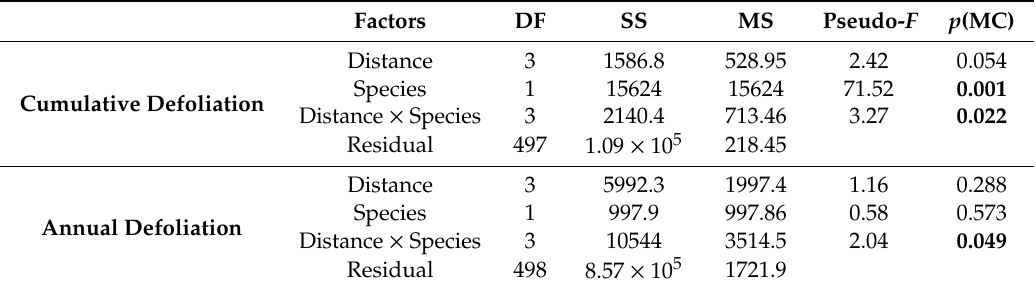
Table 3. Results of a permutational multivariate analysis of variance (PERMANOVA) for cumulative and annual defoliation among distance, species, and distance × species, including degrees of freedom (DF), sum of squares (SS), mean squares (MS), and Monte Carlo permutation test p -values ( p (MC)). Values in bold are